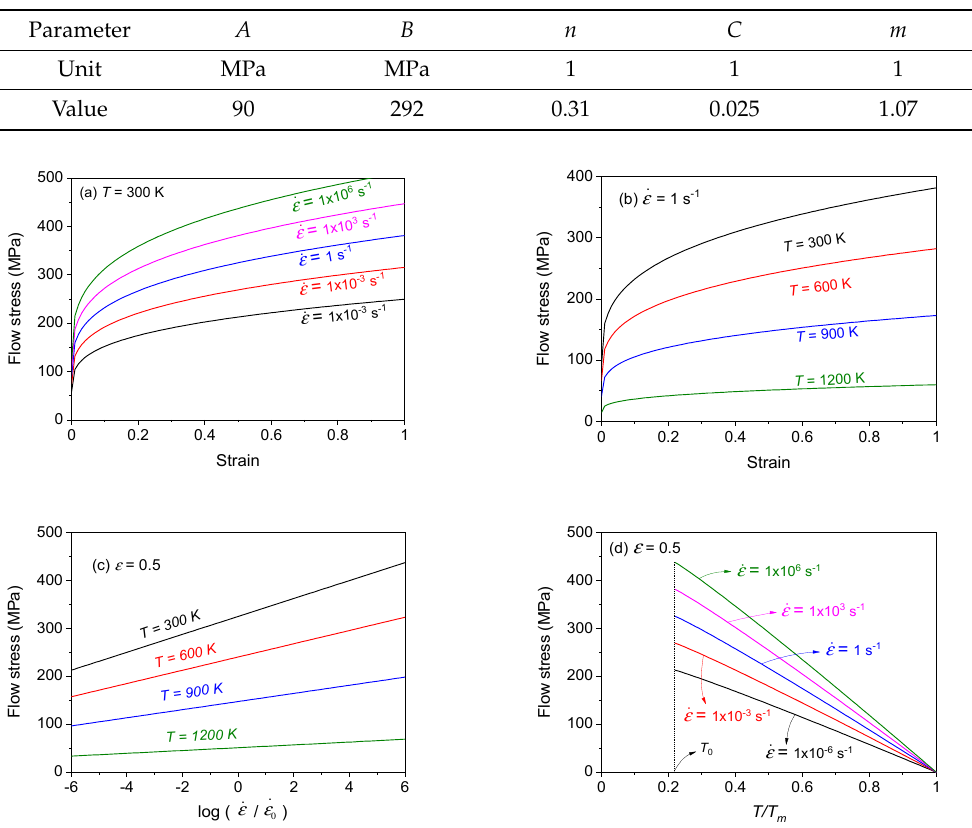
Table 1. Parameters of the JC model for OFHC [10] (